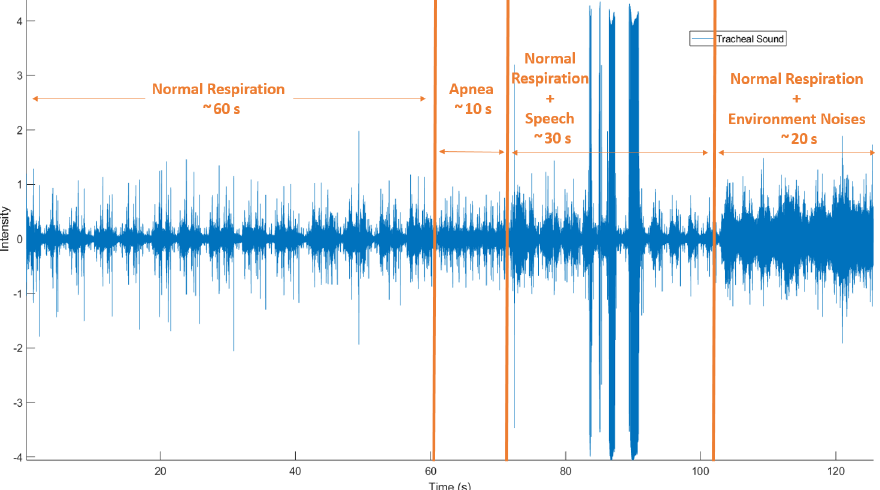
Figure 3. Recording procedure: 0–60 s normal respiration (NR); 60–70 s apnea (holding breathing spontaneously, AP); 70–100 s normal respiration + speech (RS); 100–120 s normal respiration + environmental noise (RN).